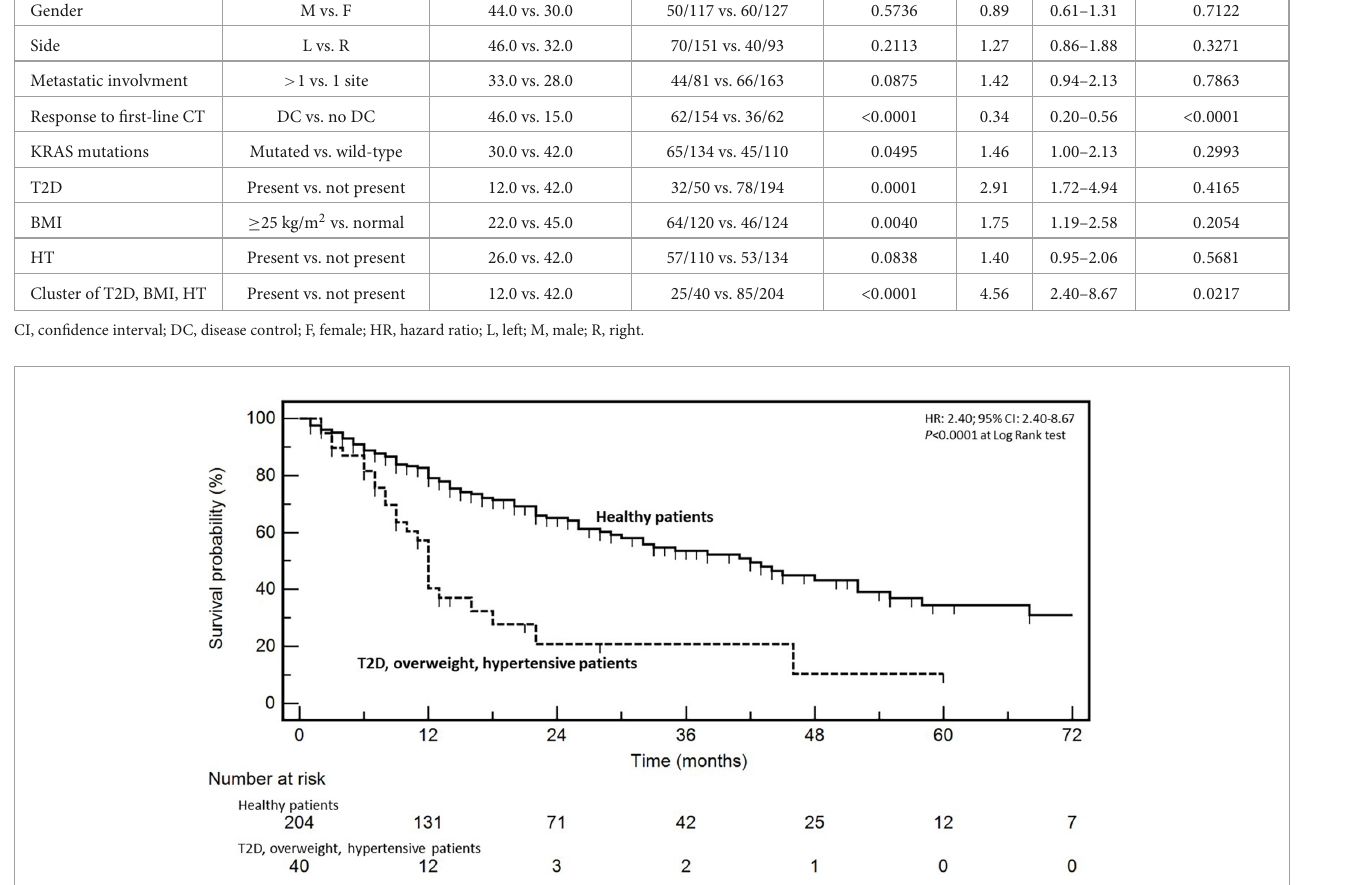
FIGURE1 Kaplan–Meyer survival curves according to the presence of type 2 diabetes, body-mass index ≥ 25 mg/m 2 and hypertension in metastatic colorectal cancer patients (healthy patients are those without diabetes, hypertension, and overweight). Hazard ratios (HR), confidence intervals (CI), and P at log-rank test are embedded in the